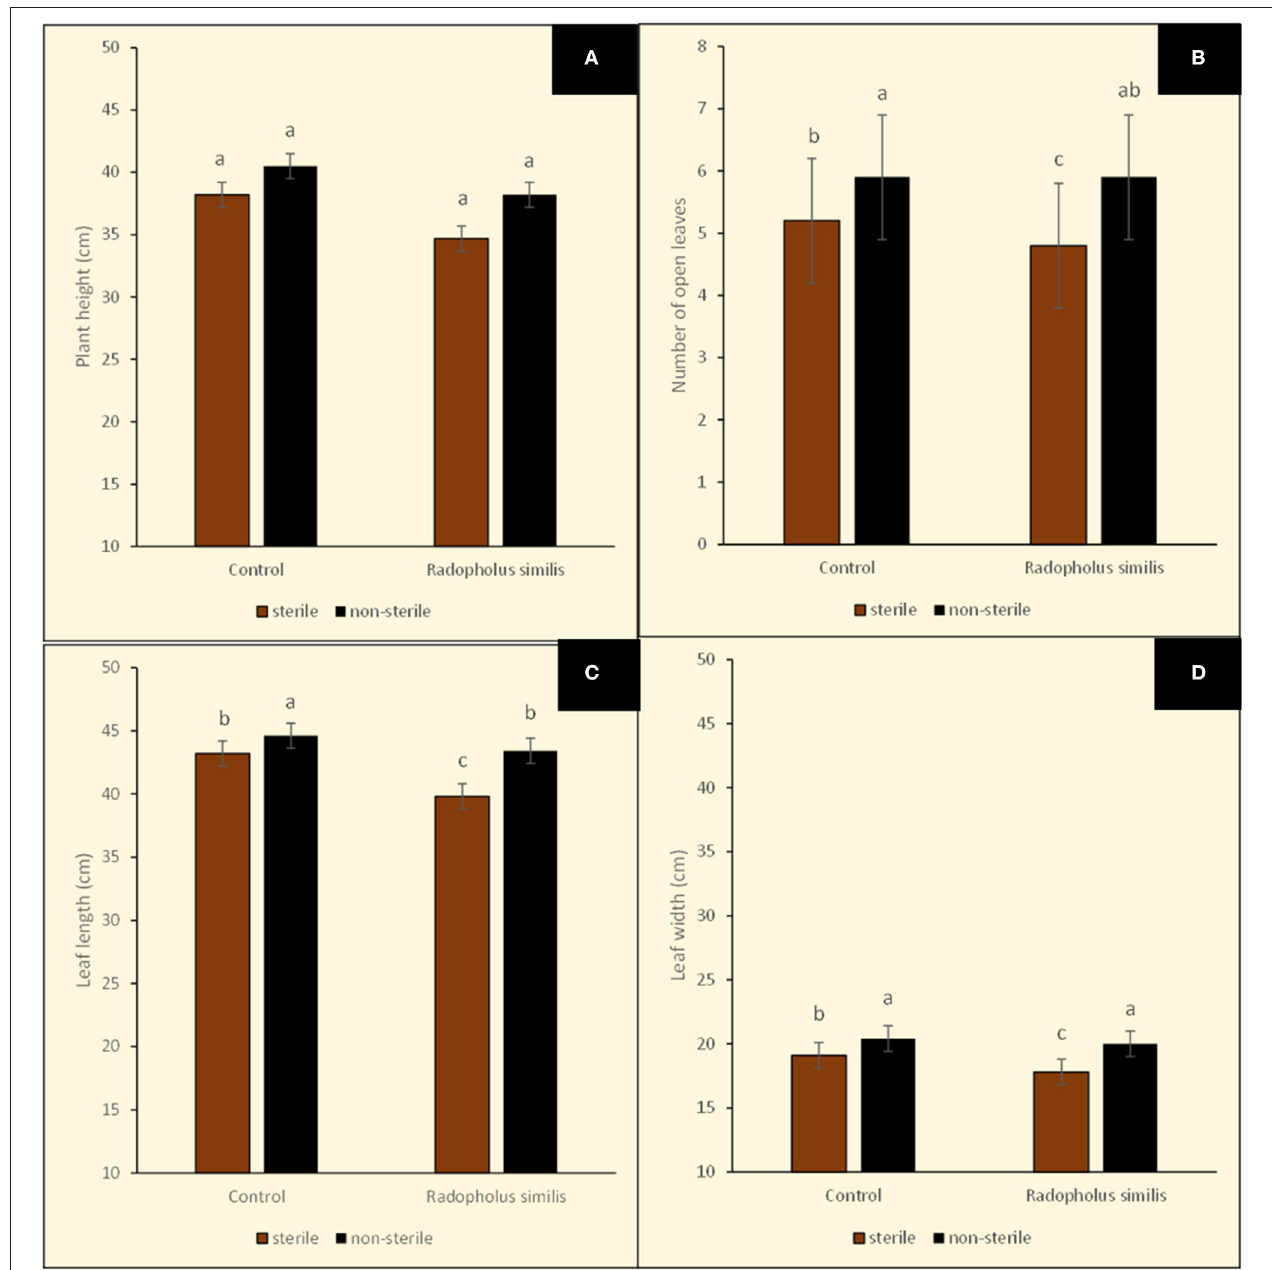
FIGURE 6 | Sizes of potted tissue culture banana plants either inoculated with Radopholus similis or not inoculated with the nematode and grown in either sterile soil or non-sterile soil supplied with complete nutrient solution. (A) Plant height, (B) Number of leaves, (C) Leaf length, and (D) Leaf width. Bars with the same letter represent values that are not statistically different ( p > 0.05; more details in Table 1 ).